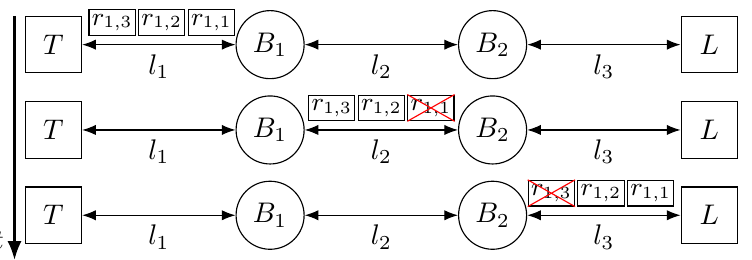
Figure 6. Behaviour of the approach B of the PTRF mechanism in the presence of temporary faults in the